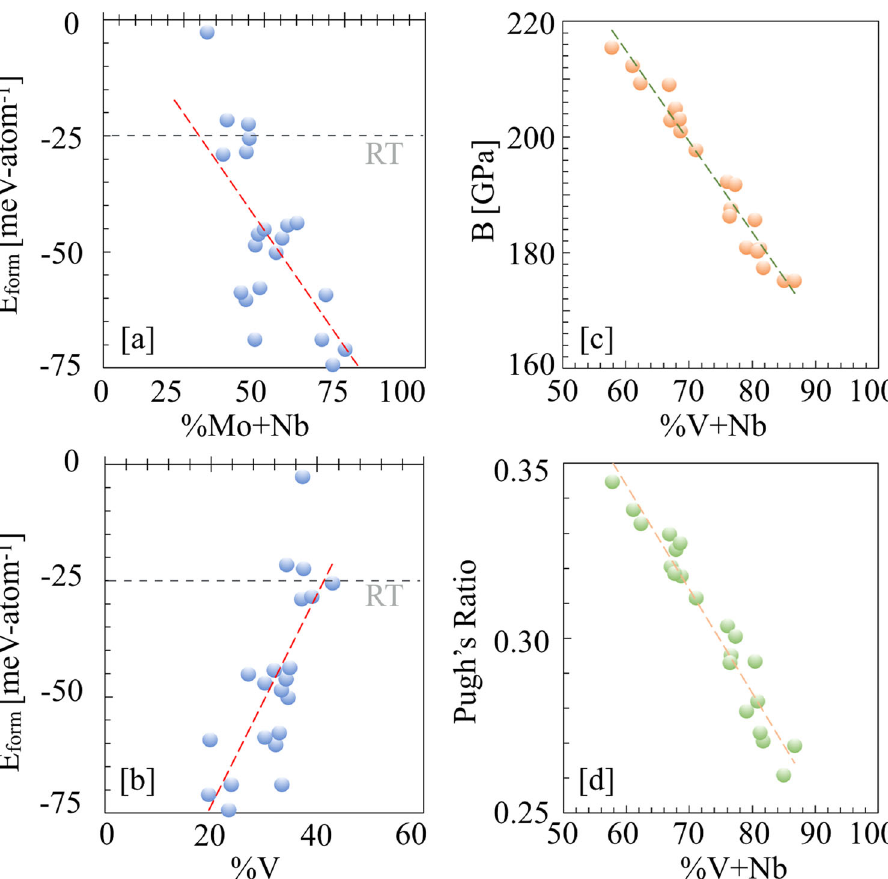
Fig. 6 Phase stability, intrinsic-strength, and ductility. a , b Formation energy plotted with respect to Mo + Nb and V concentration for 21 MPEAs in Table 2. c Intrinsic strength (bulk-moduli), and d Pugh ’ s ratio with respect to V + Nb